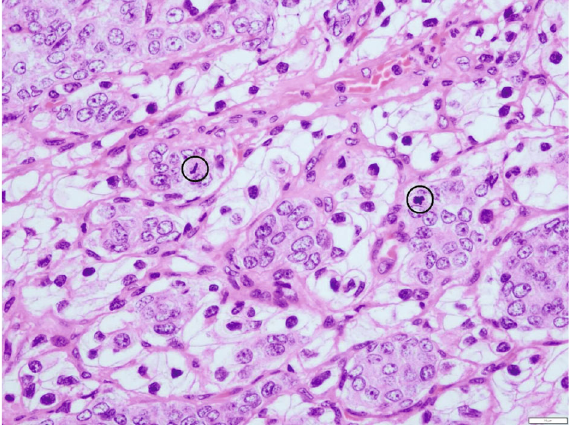
Figure 4: Microscopic examination of the basal nodule biopsy specimen with a high-power fi eld showing the two neoplastic components (H&E, 400x). Note the two mitotic fi gures on the breast cancer